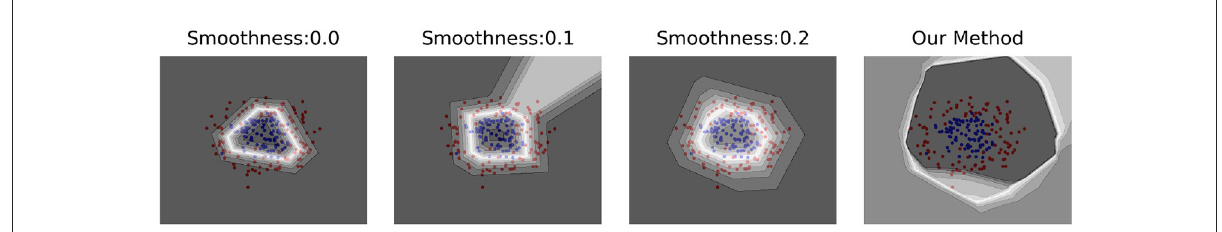
FIGURE2 The effect of this method with the toy dataset. This toy dataset has two dimensions, represented by red and blue dots in a ring-like distribution with inconsistent diameters. The two rings have a diameter ratio of 0.4 and are generated using a Gaussian noise of 0.2. A gradient color from black to white is used to represent the maximum value predicted by the model for that coordinate point, with darker colors representing larger values. The first three subplots are models obtained under different “semantic perspectives,” which are trained using smoothing labels with smoothing coefficients of 0.0, 0.1, and 0.2, respectively. The rightmost subplot shows the model learned using our method without SPBN for the three “semantic perspectives.” Obviously, our method more reasonably discriminates the region outside the two circles as a low confidence